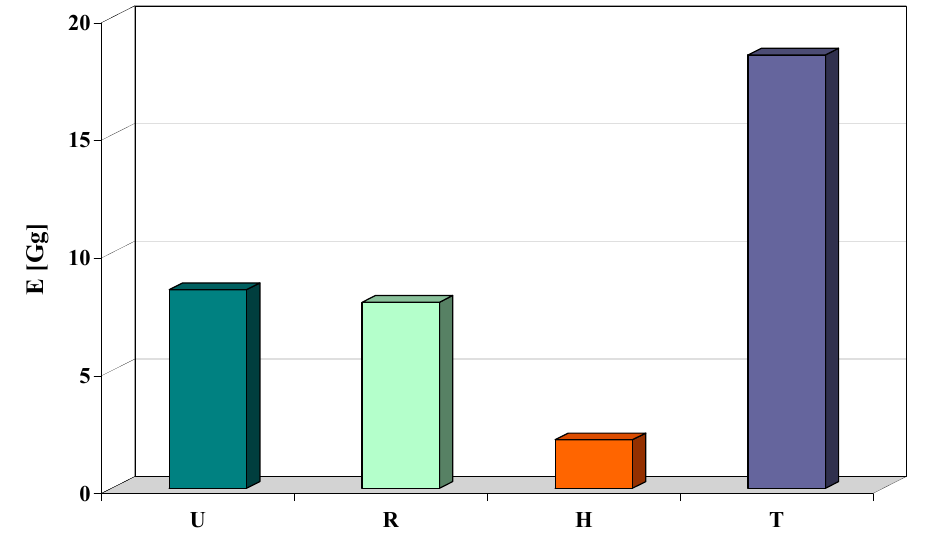
Figure 9. National annual emissions (E) of particulate matter PM10 (PM10-T) under different traffic conditions: urban (U), rural (R), highway (H) and total (T).